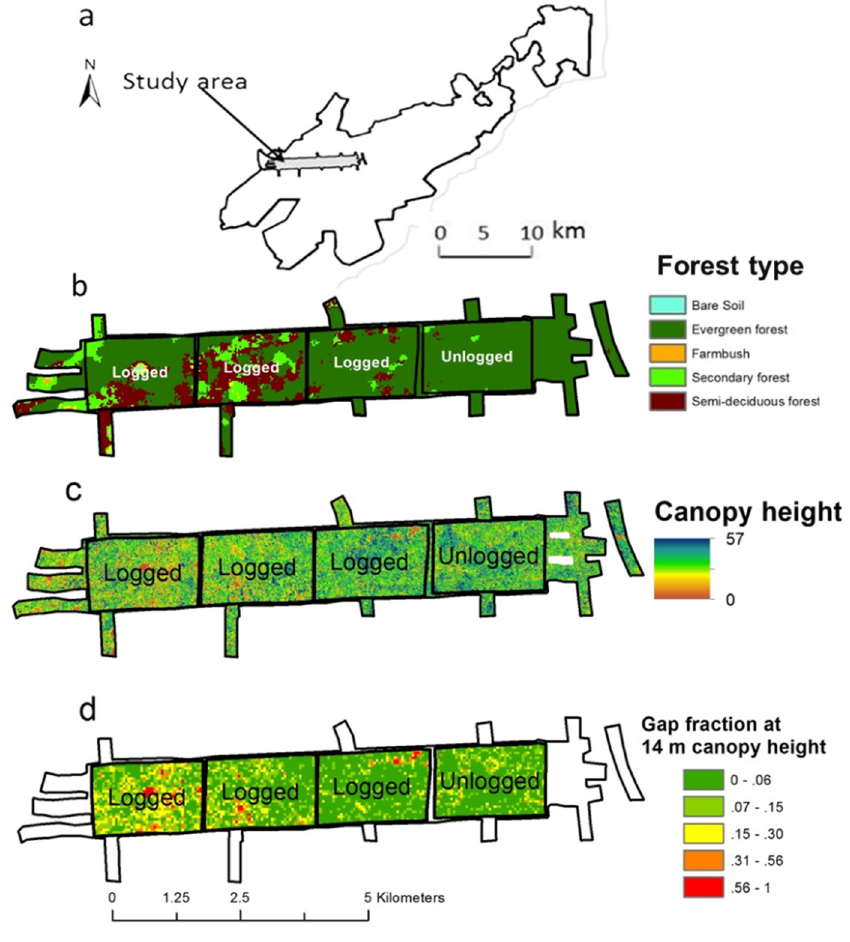
Figure 1. ( a ) A map showing the boundaries of Gola National Park (black) and the study area (grey); ( b ) division of the study area into equal-area blocks for the gap size frequency analyses, with forest types shown (see [46] for details); ( c ) a canopy height model derived from LiDAR cloud point; and ( d ) estimated gap fractions within the 14–15 m height tier, estimated from the LiDAR point cloud, in 0.25 ha sub-blocks. The blocks were numbered, from east to west: 1, unlogged block; 2, eastern logged block; 3, central logged block; and 4, western logged